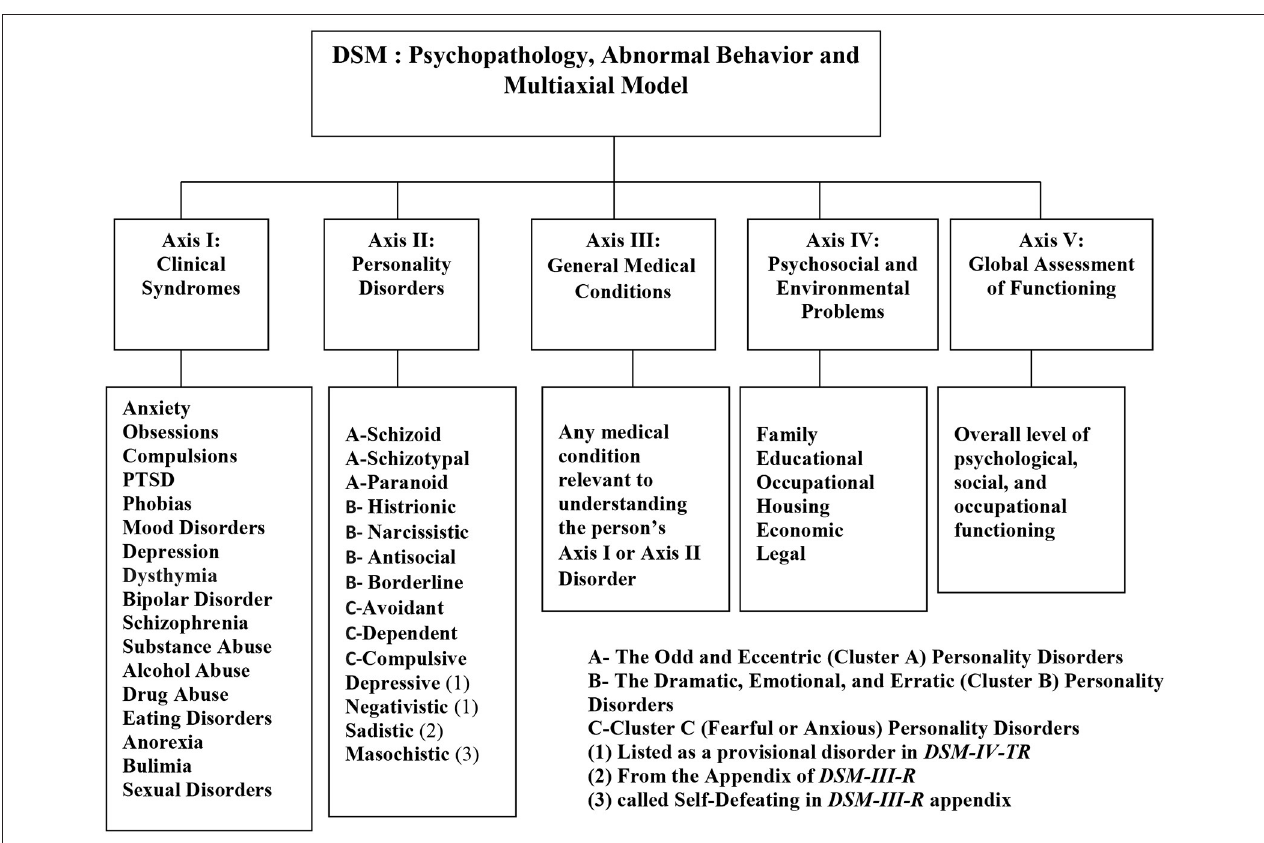
FIGURE 2 | Psychopathology, abnormal behavior, and the multiaxial